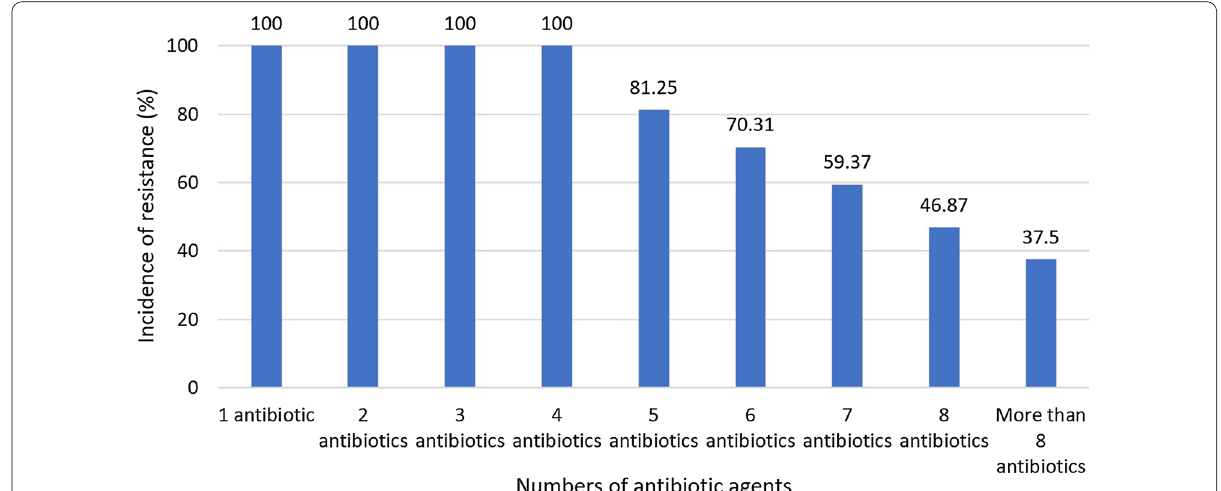
Fig. 1 Prevalence of multi-drug resistant S. aureus bacteria isolated from ready-to-eat food samples; the results were interpreted from a total of 64 S. aureus